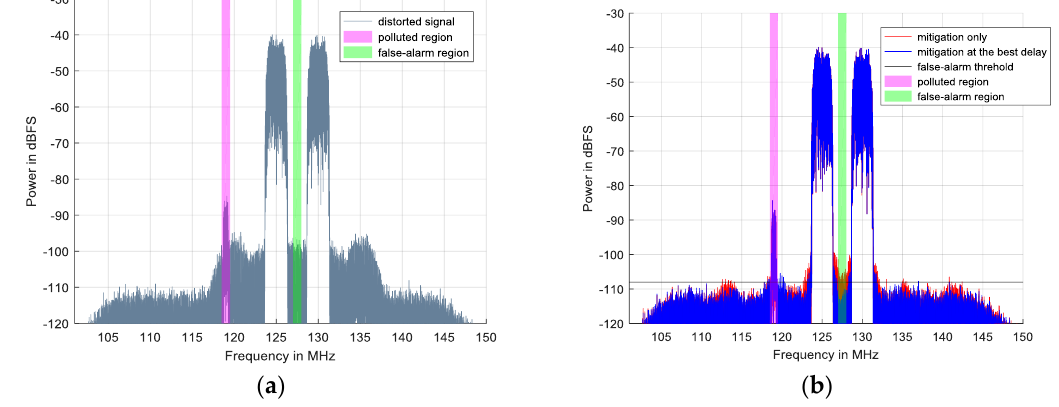
Figure 5. Nonlinearity mitigation results of simulation signals including two strong 16QAM signals and one weak 16QAM signal: ( a ) distorted signals; and ( b ) signals after nonlinearity mitigation.